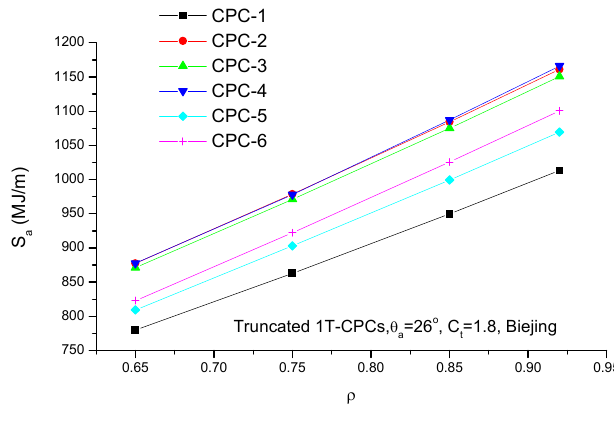
Figure 11. As in Figure 10 but for truncated 1T ‐ CPCs.